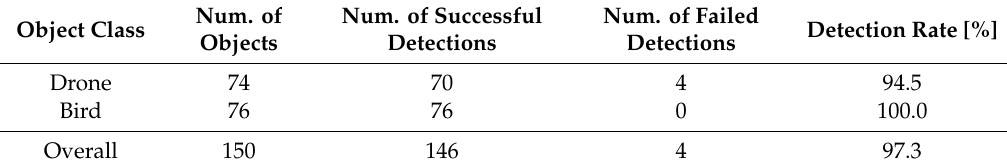
Table 5. The detection rate of the detector trained to two classes (drone and bird).